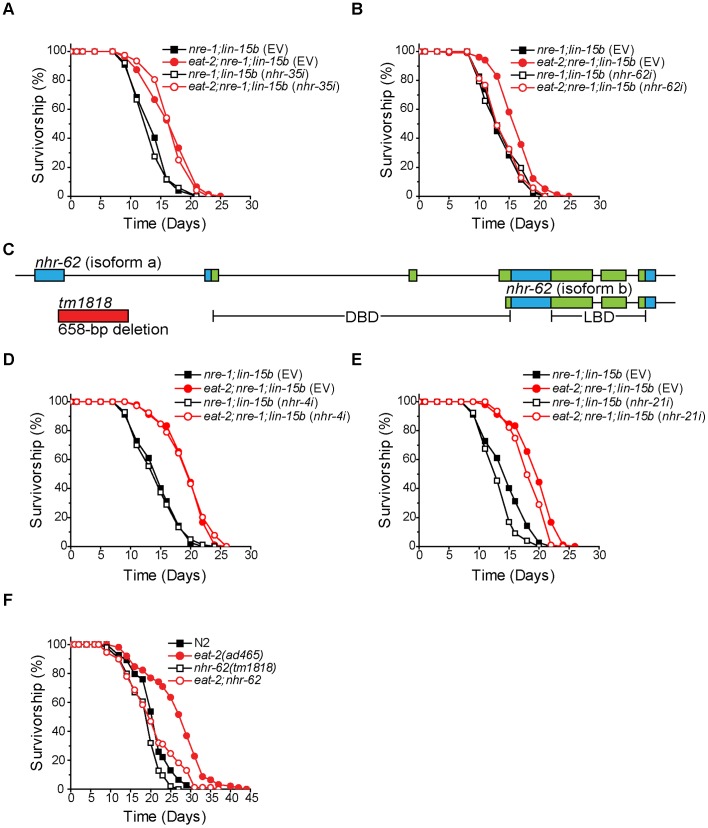

nhr-62 mediates the longevity response to dietary restriction.(A) eat-2;nre-1;lin-15b worms fed either empty vector or nhr-35 RNAi had a significant increase in lifespan compared to ad libitum controls (p<0.001). See Figure S1 for other NHRs. (B) eat-2;nre-1;lin-15b fed nhr-62 RNAi do not have a DR-induced lifespan extension (p = 0.907). (C) Gene model for nhr-62. Boxes indicate exons and lines indicate introns. The DNA binding domain (DBD) and the ligand binding domain (LBD) are indicated in green. (D,E) eat-2;nre-1;lin-15b worms fed either empty vector, nhr-4 or nhr-21 RNAi had a significant increase in lifespan compared to ad libitum controls (p<0.001). (F) eat-2(ad465) had a significant increase in lifespan compared to wild-type (N2) (p<0.001). Mutation of nhr-62 suppressed the lifespan extension of eat-2(ad465) worms (p<0.001). p-values calculated by the log-rank test.